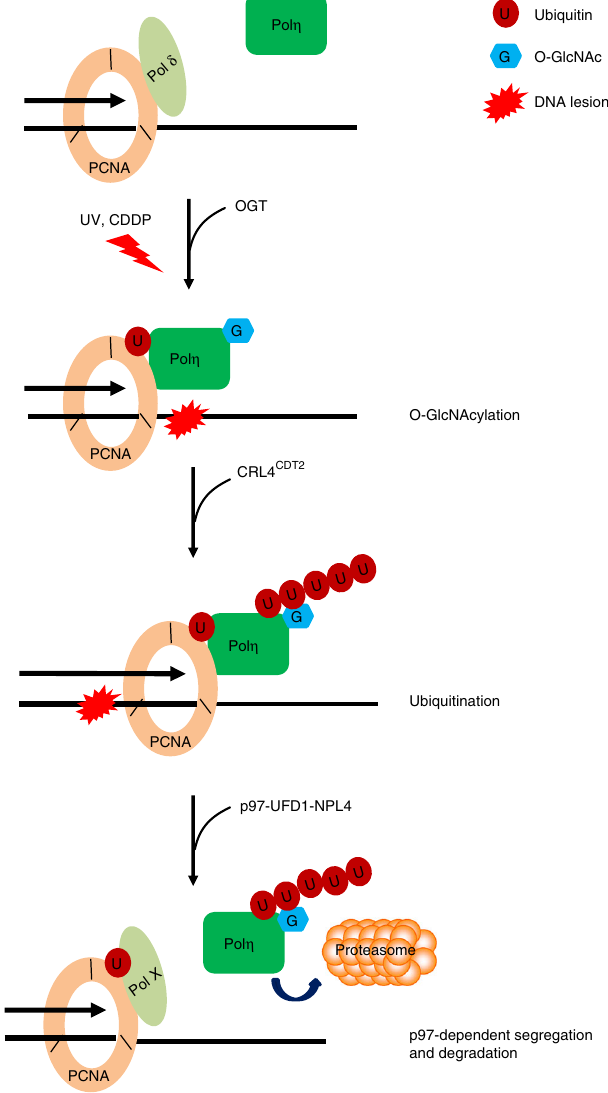
Fig. 7 A proposed model depicting the role of Pol η O-GlcNAcylation in its removal after TLS. Upon UV or CDDP exposure, Pol η is recruited to stalled replication forks and gets O-GlcNAcylated by OGT. Once Pol η ’ s role in TLS is completed, O-GlcNAcylated Pol η is ubiquitinated by CRL4 CDT2 E3 ligase complex. The polyubiquitinated Pol η is then recognized by p97-UFD-NPL4 complex, resulting in its dissociation from replication forks and